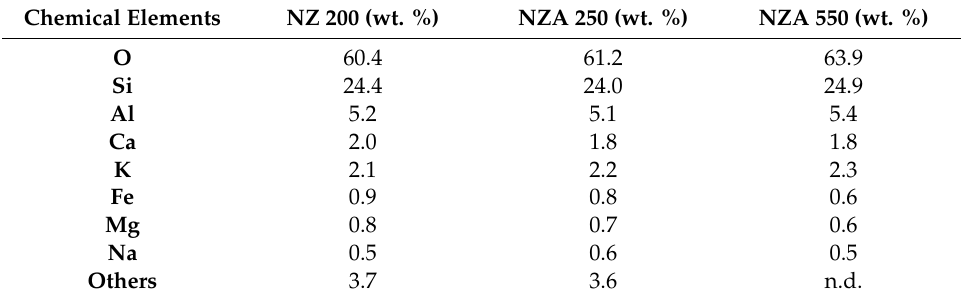
Table 1. The composition of thermally activated zeolite samples with smaller particle sizes ( < 0.5 mm) expressed as weight (wt. % ).